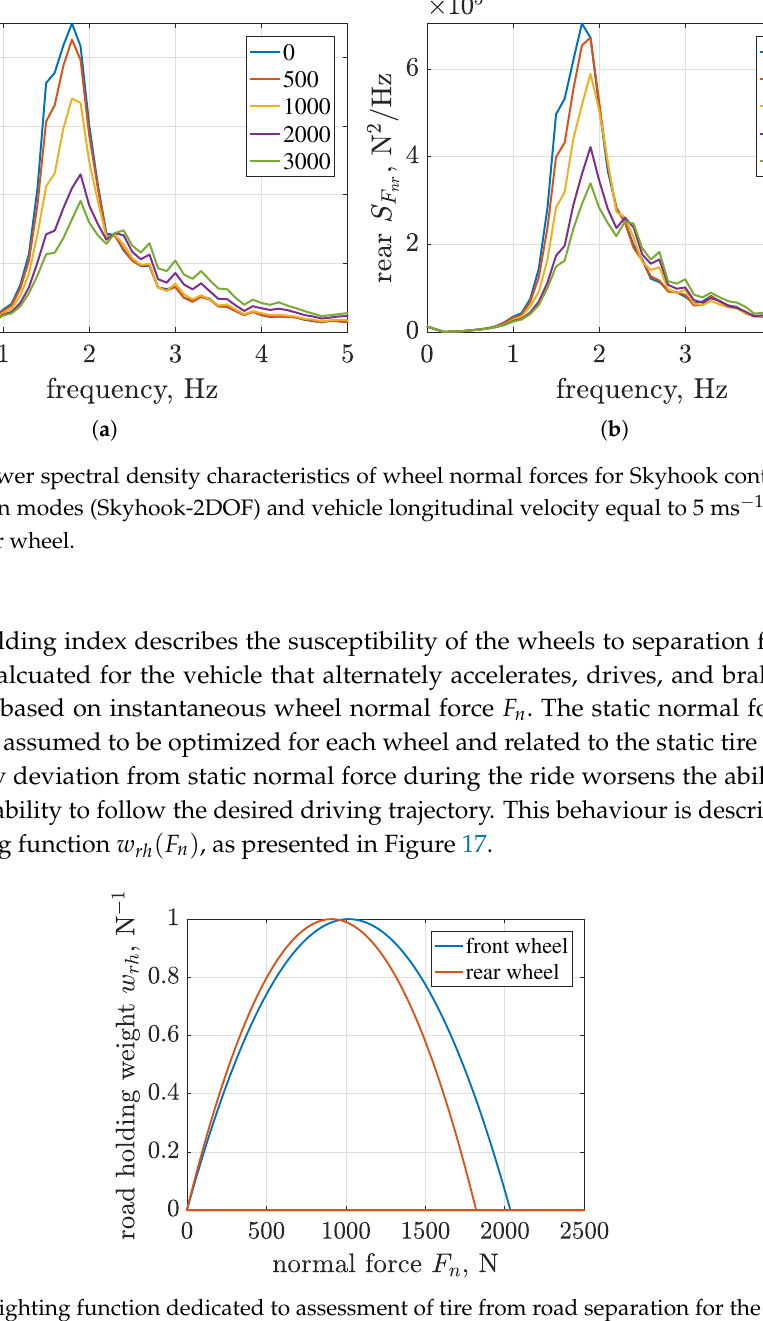
Figure 17. Weighting function dedicated to assessment of tire from road separation for the front and rear